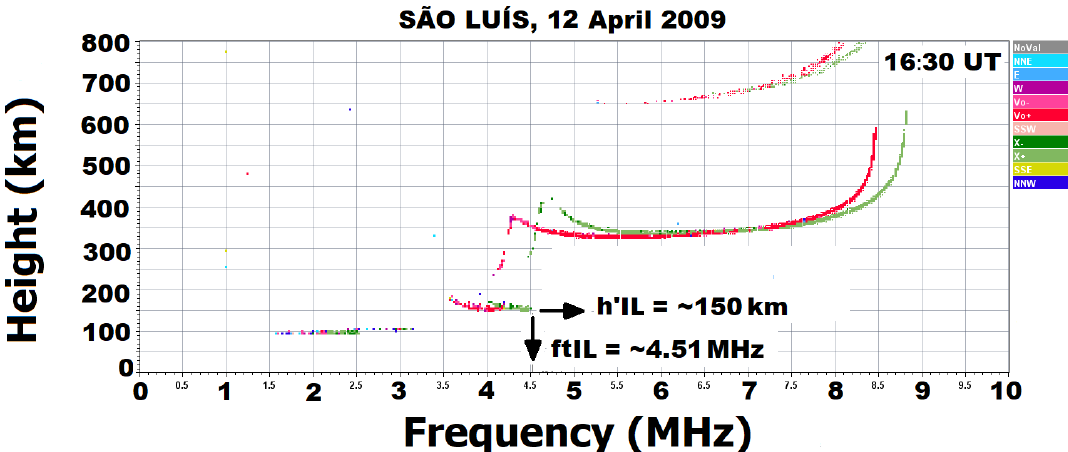
Figure 1. Ionogram over São Luis on 12 April 2009. The virtual height ( h (cid:48) IL) and the top frequency (ftIL) of the intermediate layer are indicated in this figure. The ordinary and extraordinary traces are represented by red and green colors, respectively.